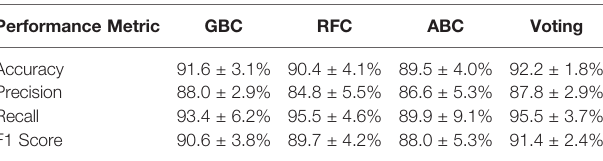
TABLE 4 | Performance metrics for the top three weighted individual models (1 st = Gradient Boosting Classi fi er [GBC], 2 nd = Random Forest Classi fi er [RFC], 3 rd = AdaBoost Classi fi er [ABC]) and the voting model.